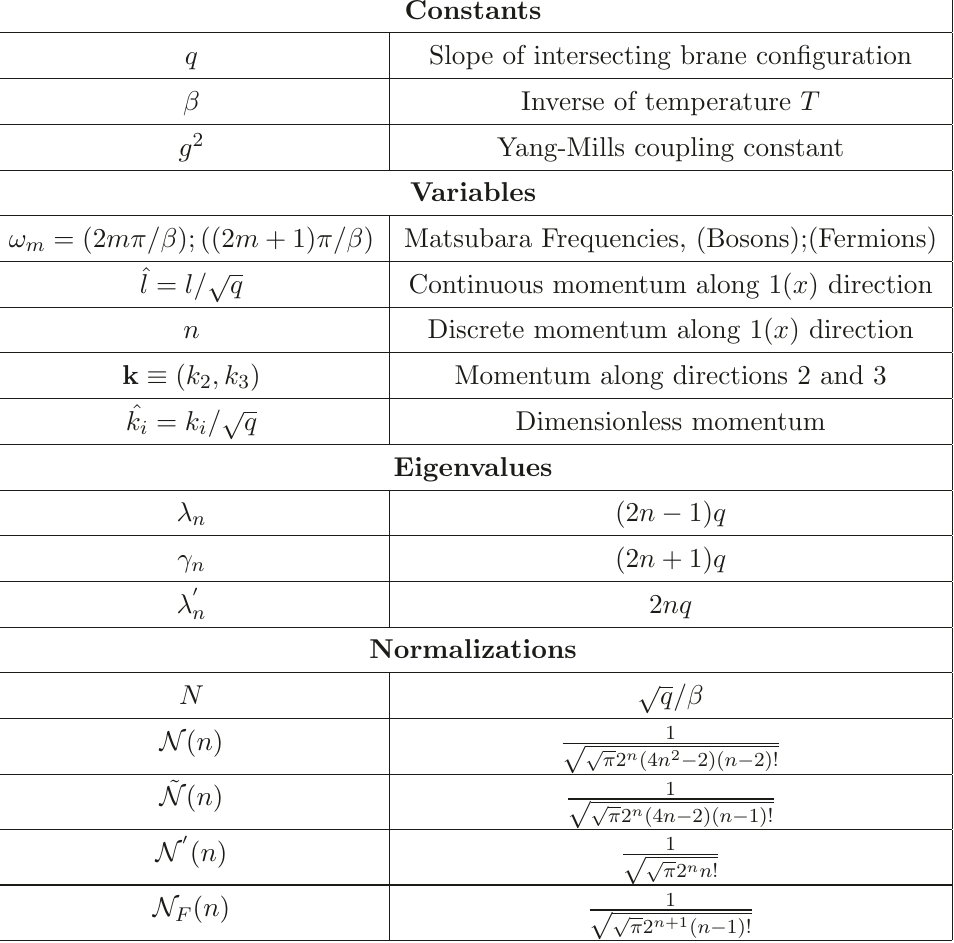
Table 1 . Constants and